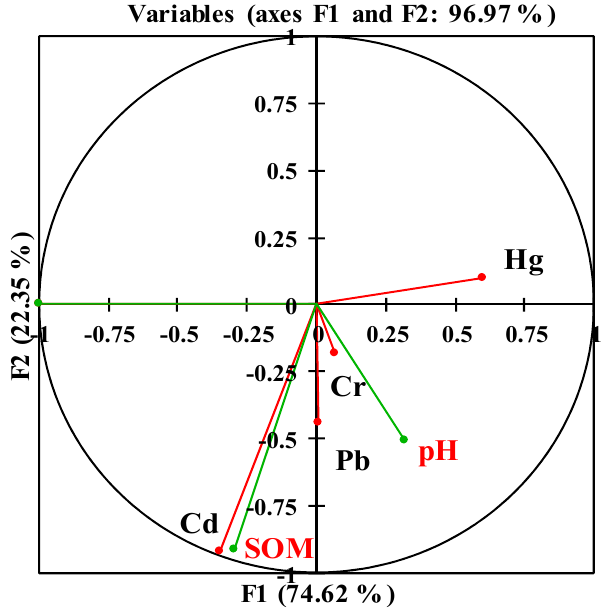
Figure 3. Ordination diagram based on the CCA of soil properties (in black) and heavy metals (Cd, Hg, Pb, and Cr) in the soil (in red).